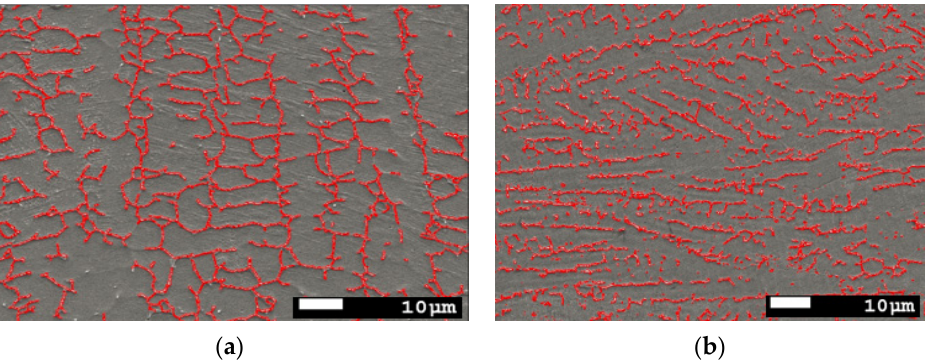
Figure 12. Ferrite proportions measurements of 316L, ( a ) TIG Weld Zone and ( b ) ATIG Weld Zone (SEM. magnification 500×). (SEM. magnification 500 × ).